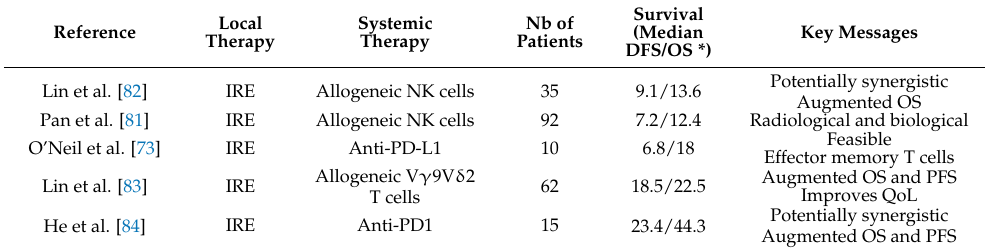
Table 2. Clinical phase I/II